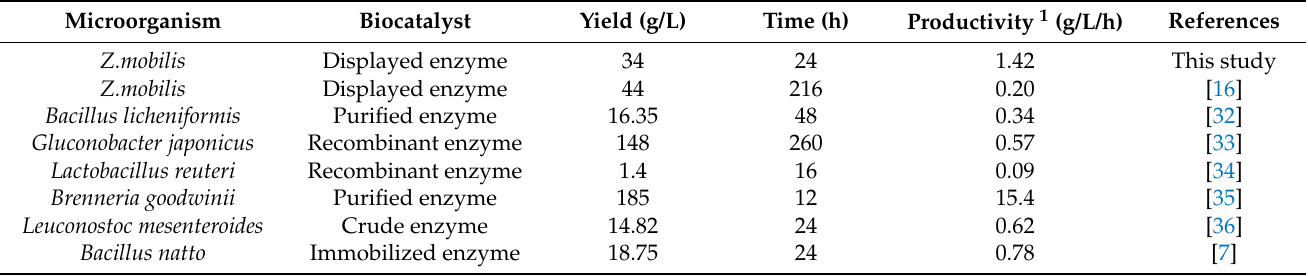
Table 1. Levan biosynthesis from sucrose by microbial